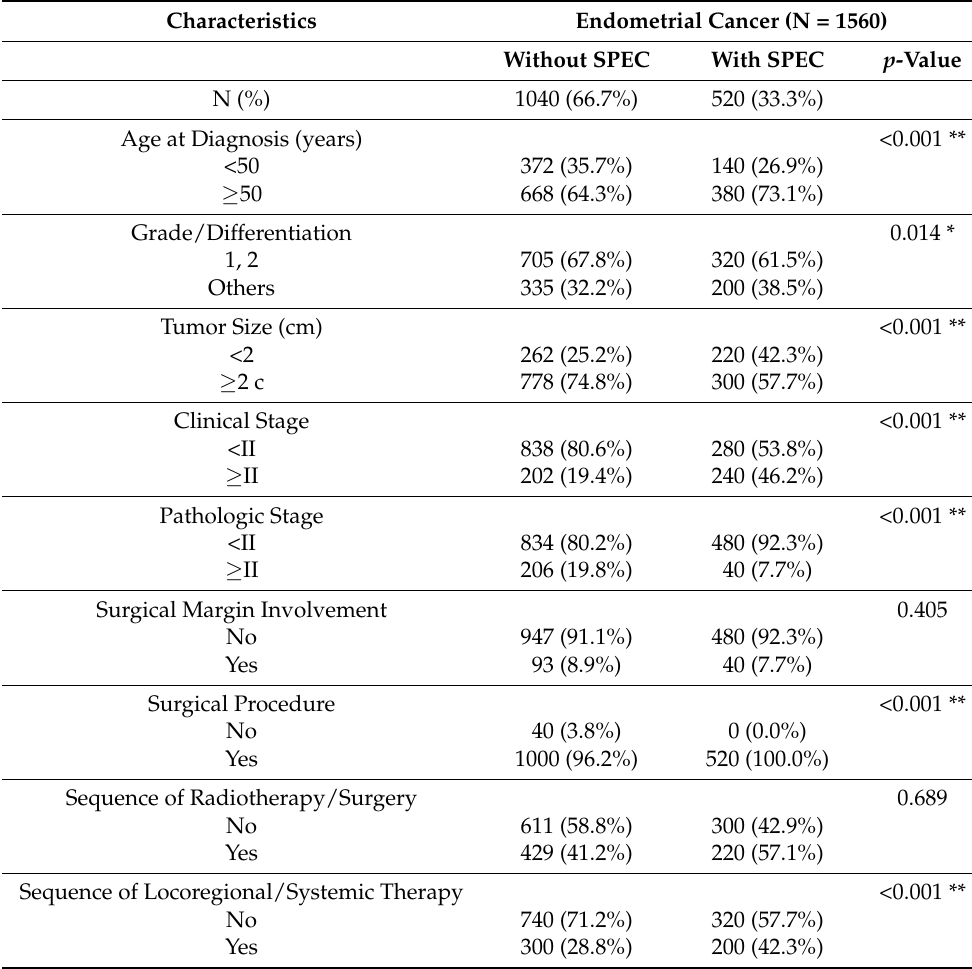
Table 2. Subject demographics of all primary endometrial